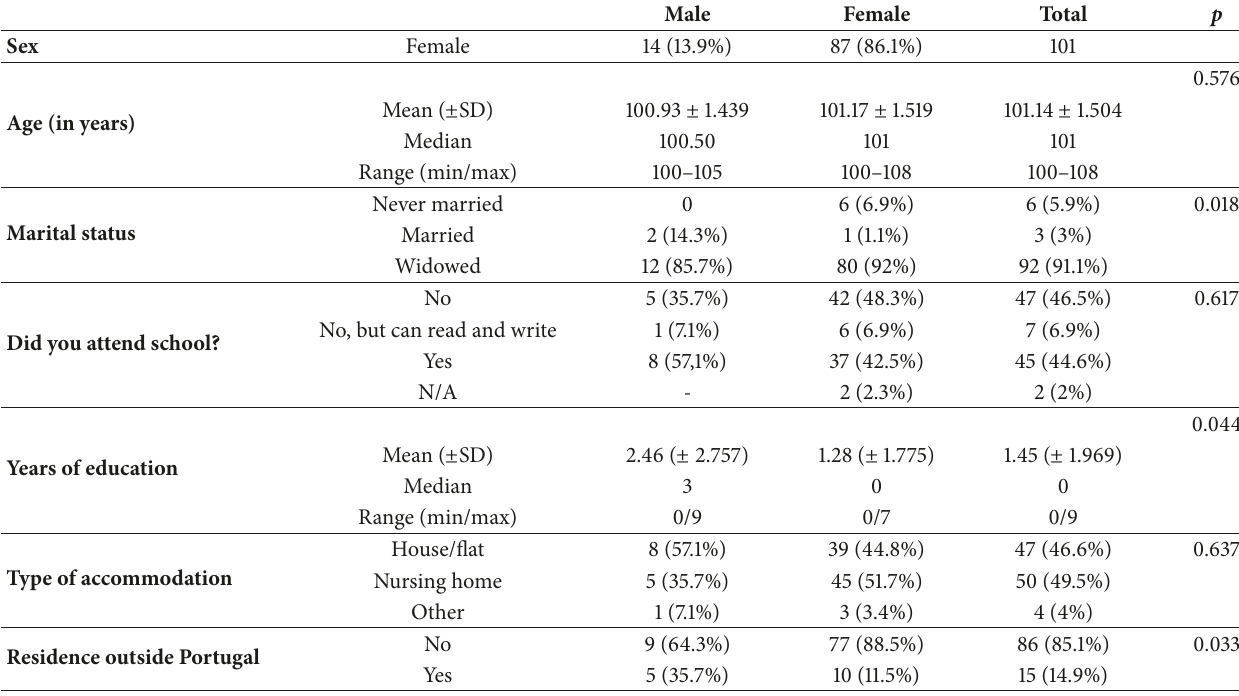
Table 1: Sociodemographic profile of the Beira Interior Portuguese centenarians ( 𝑁 = 101) by sex.